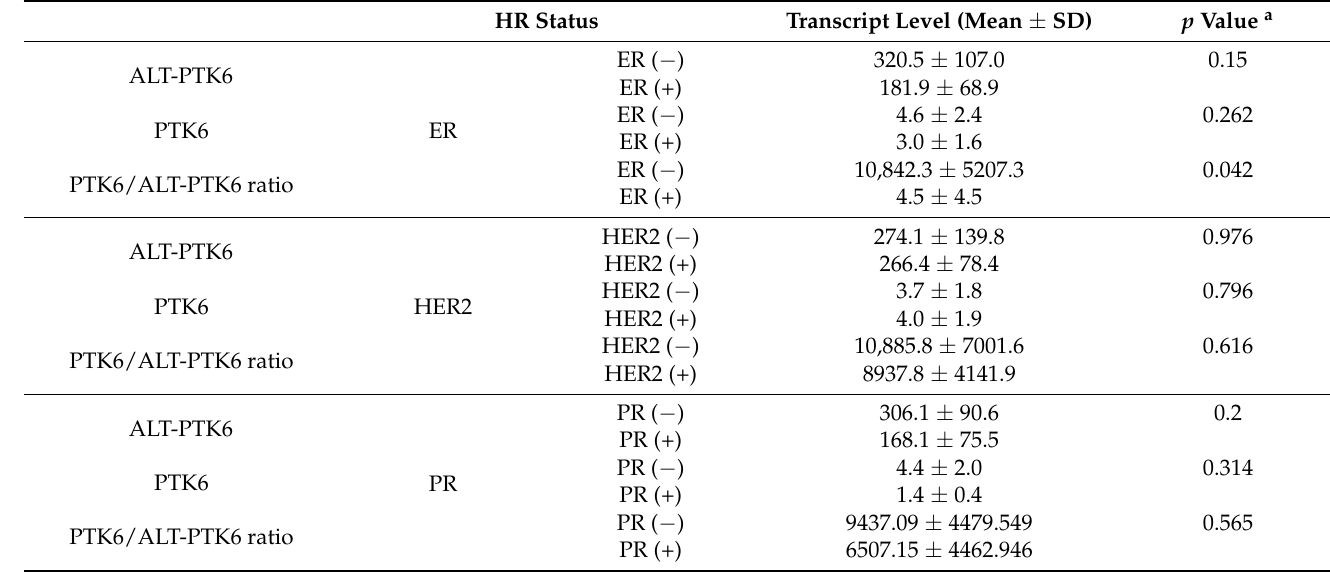
Table 2. Expression levels of ptk6 , ALT-PTK6, and ptk6 /ALT-PTK6 ratio in relation to hormone receptor status of breast